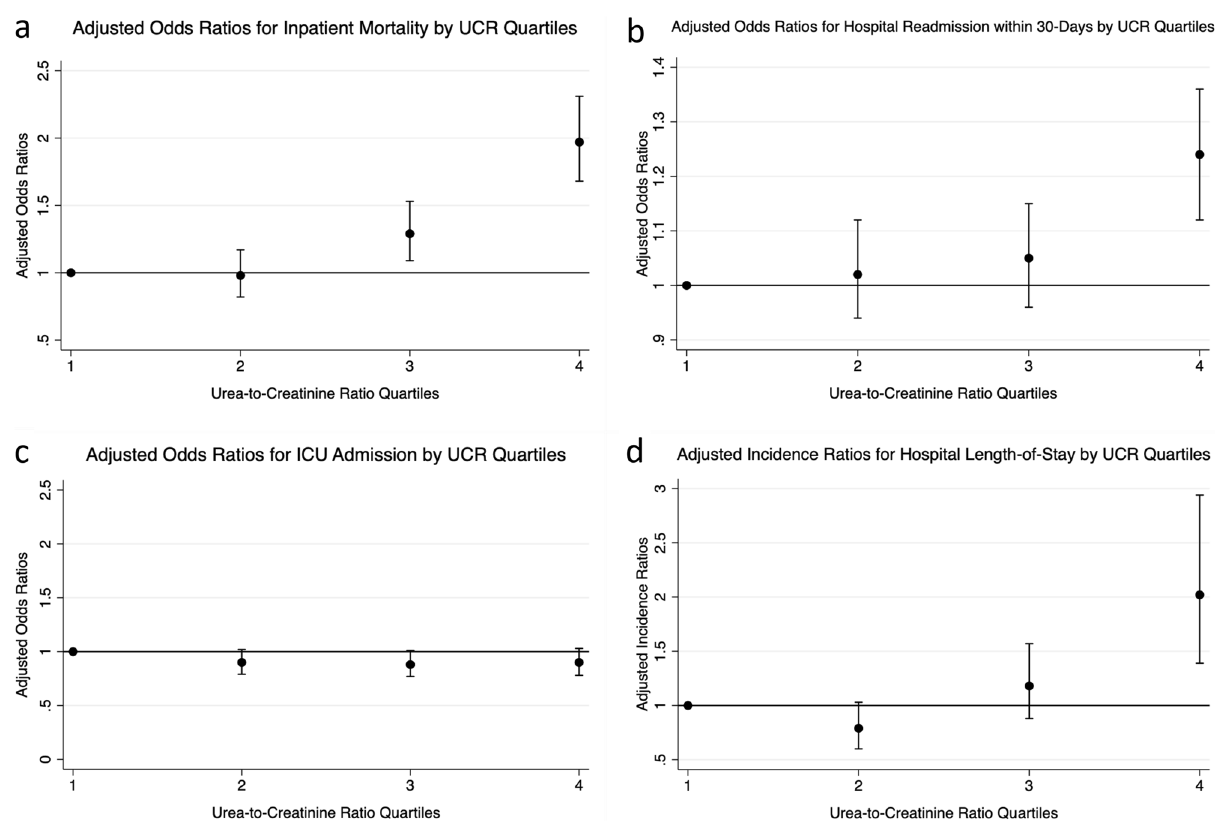
Figure 3. Clinical Outcomes by UCR Quartile. All graphs show adjusted odds ratios (or incidence ratios in the case of hospital length-of-stay) with 95% confidence intervals from multivariate analysis for the clinical outcomes of interest by admission UCR quartile, represented by a dot with error bars. The dotted grey line represents an OR of 1.00. Data points with 95% confidence intervals that cross the grey line are not considered statistically significant. Models are adjusted for age, sex, CCI score, eGFR, GIT bleed, heart failure and hypovolaemia. ( a ): Adjusted Odds Ratios for Inpatient Mortality by UCR Quartile. ( b ): Adjusted Odds Ratios for Readmission to Hospital within 30-Days by UCR Quartile. ( c ): Adjusted Odds Ratios for ICU Admission by UCR Quartile. ( d ): Adjusted Incidence Ratios for Hospital Length-of-Stay by UCR